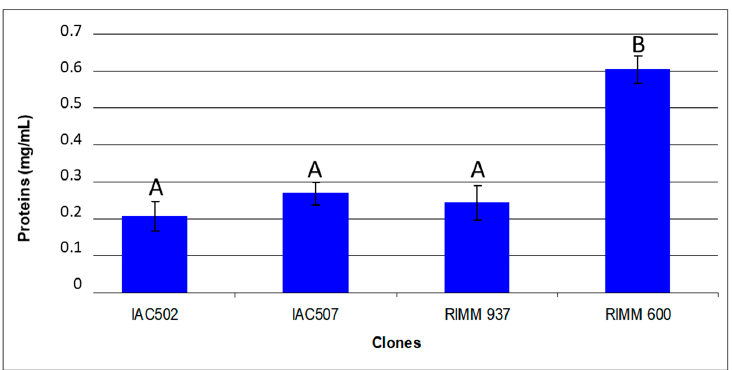
Figure 4. Average protein values in the tested rubber tree clones (IAC502, IAC 507, RRIM 937 and RRIM 600). Average values followed by the same letter do not differ, according to Tukey’s test, at 5% probability. Coefficient of variation: 32.05.